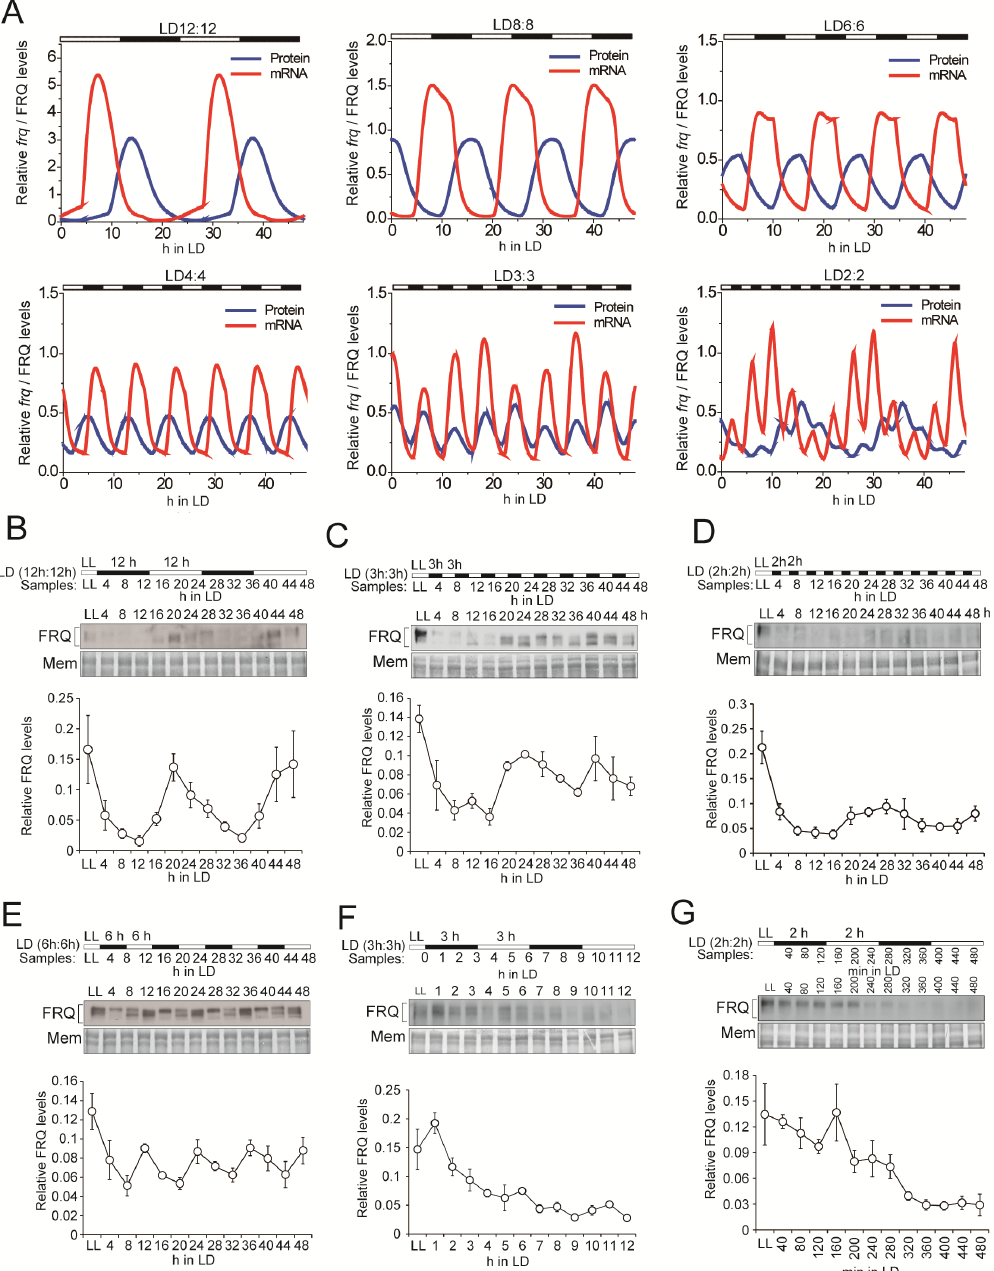
Figure 2. The FRQ protein levels under different LD routines. ( A ) Dynamic modeling results showing the time series of frq mRNA and FRQ protein under different light-dark cycles. Both the frq mRNA and FRQ protein can be entrained to LD12:12, LD8:8, LD6:6 and LD4:4. As the frequency of the light signal increases to LD3:3, the frq mRNA and FRQ protein still exhibit the oscillation with a period of approximately 6 h. If the frequency of the light signal is further increased to LD2:2, although the frq mRNA can respond to the induction by the light, the FRQ levels show the free running pattern with some fluctuations, ( B – G ) Western blot results showing FRQ levels in different LD cycles. The LD routines are LD12:12 for two cycles ( B ), LD3:3 for 48 h ( C ), LD2:2 for 48 h ( D ), LD6:6 for 48 h ( E ), LD3:3 for two cycles ( F ) and LD2:2 for two cycles ( G ), respectively. The black and white bars denote different LD regimes. Membranes (Mem) stained with Amido Black were used as loading control. The densitometric analysis of FRQ levels is shown at the bottom of each panel. Representative data of triplicates are shown. The light intensity was 5000 lux. Data are mean ± SE, n =